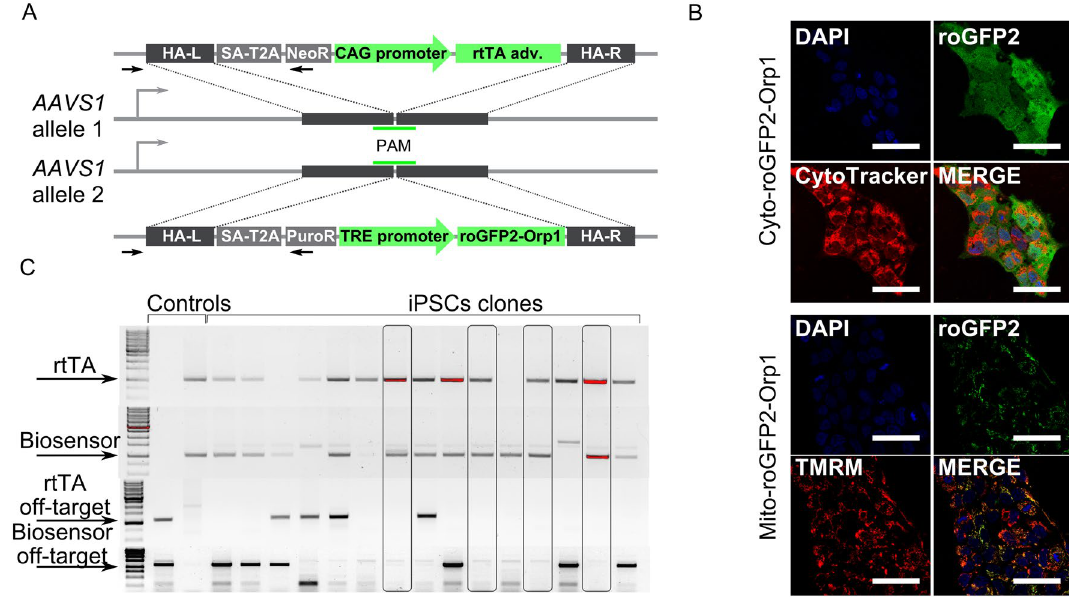
Figure 2. Generation of iPSCs expressing the Cyto-roGFP2-Orp1 and Mito-roGFP2-Orp1 biosensors. ( A ) Schematic of the biosensor and transactivator for doxycycline-controllable expression inserts in the AAVS1 locus. In one allele, homologous arms (HA-L—left, HA-R—right) flank the splice acceptor site (SA), T2A peptide, neomycin-resistance gene, and reverse tetracycline-controlled transcriptional activator (rtTA) under control of the CAG promoter. In another allele, homologous arms flank the splice acceptor site (SA), T2A peptide, puromycin-resistance gene, and the biosensor’s sequence under control of the TRE-promoter. The primers used to detect the target insertions are represented as black arrows. ( B ) Representative images of live iPSCs expressing the Cyto-roGFP2-Orp1 (top) or Mito-roGFP2-Orp1 (bottom) biosensors 24 h after the addition of 2 mg/ml doxycycline in the medium. Scale bar 50 μm. TMRM—tetramethylrhodamine methyl ester perchlorate. ( C ) Screening of the iPSC clones for the target (two top gels) and off-target (two bottom gels) inserts. The arrows mark target PCR products. The clones positive for the target and negative for the off-target inserts are in